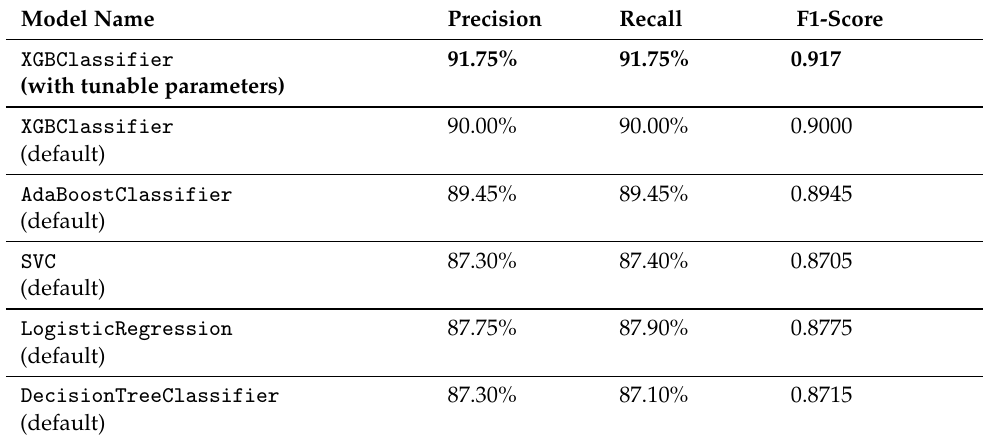
Table 7. Classification results of individual algorithms in